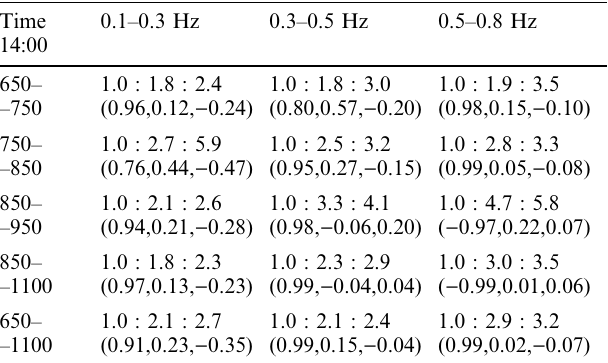
Table 2. The ratio of three eigenvalues of variational matrix calculated for three frequency ranges during five time periods and the wave vector corresponding to the smallest eigennumber